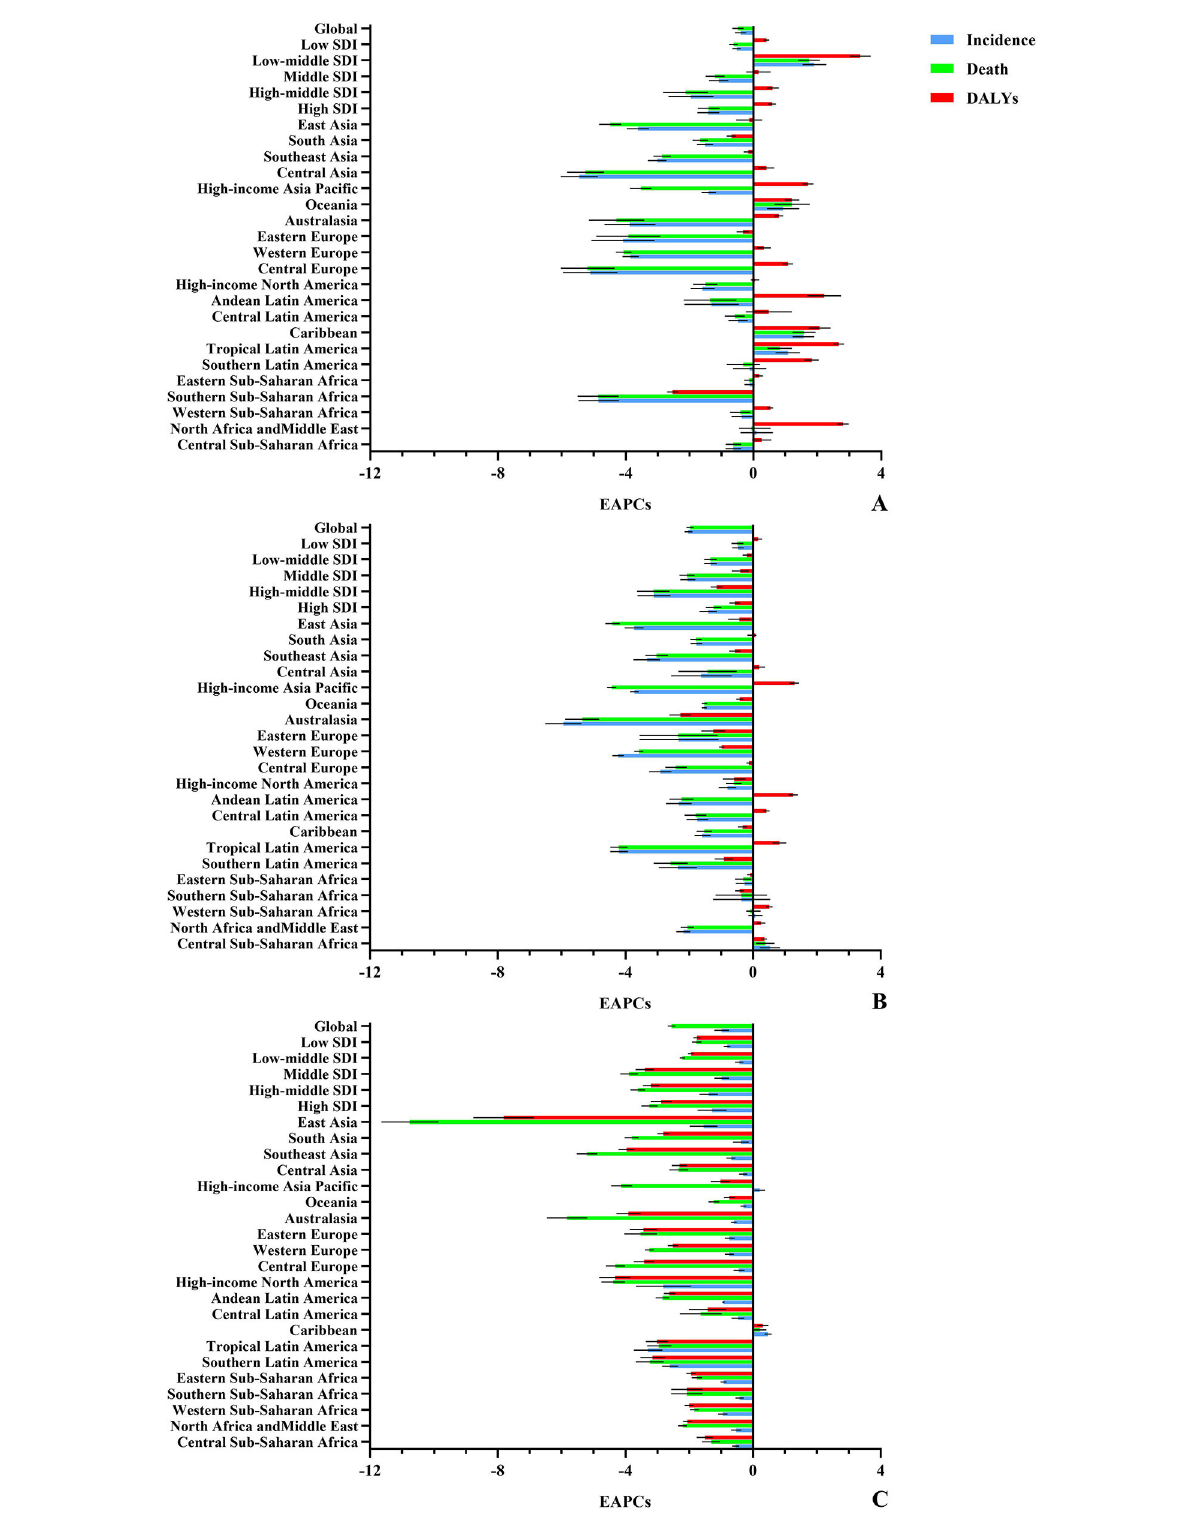
FIGURE1 Trends in the ASR of the FV burden, 1990–2019. The FV burden included incidence, death, and DALYs of PVF (A) , SHF (B) , and UFI (C) , in the period 1990–2019. PVF, physical violence; SHF, self-harm by firearm; UFI, unintentional firearm injuries; DALYs, disability-adjusted life